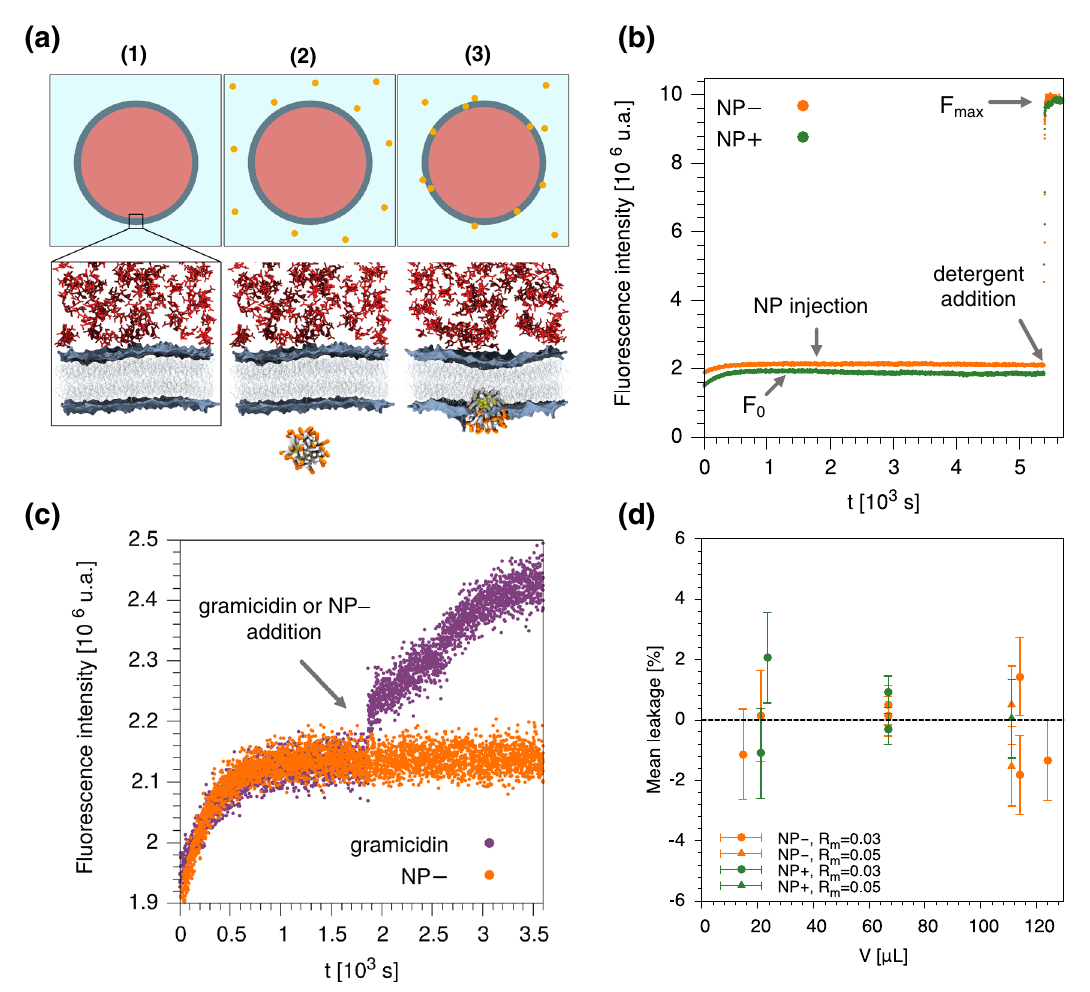
Figure 2. Leakage experiments on NP-vesicle suspensions. ( a ) Schematic drawing illustrating the three steps of our dye-leakage assays on calcein-loaded POPC liposomes: (1) liposomes before NP addition; (2) NP injection, (3) liposomes during the NP uptake. Simulation snapshots of a membrane portion are reported in the second row; membrane lipid heads are shown in blue (surface representation) and lipid tails in light-gray, calcein molecules in red, charged groups of the NP ligands in orange, and the rest of the NP in white (ligands) and yellow (Au core). ( b ) Typical leakage traces recorded before and after the addition of NP− (orange curve) and NP+ (green curve) to POPC liposomes. NP− and NP+ were added after the first 1800s, as explained in detail in “Methods”. F 0 is the fluorescence level immediately before NP addition, while F max is the final fluorescence level after the detergent-induced liposome rupture. In general, for both positively and negatively charged Au NPs, no content release (i.e. fluorescence intensity increase) was recorded during the NP-membrane interaction. In this specific experiment, NP at R m = m NP / m lip = 0.03 were added (V NP− = 14.6 μL, V NP+ = 23.4 μL). ( c ) First 3600 s of the curve in ( b ) compared to the leakage-inducing effect of a low amount of gramicidin (250 nM). ( d ) Normalized fluorescence intensity of calcein (i.e. mean leakage %) as a function of the NP added volume. NP− (orange) and NP+ (green) at R m = 0.03 ( ) and 0.05 ( ▲ ) were tested. The mean leakage % was calculated over the last 10 min before the addition of the ●